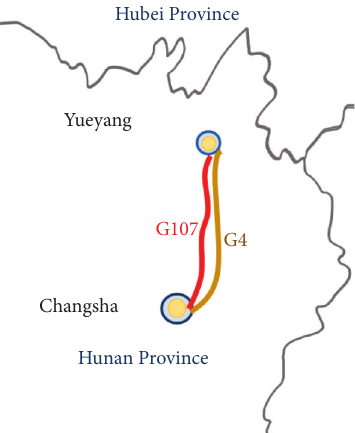
Figure 2: Diagram of the highway connection between Changsha and Yueyang.